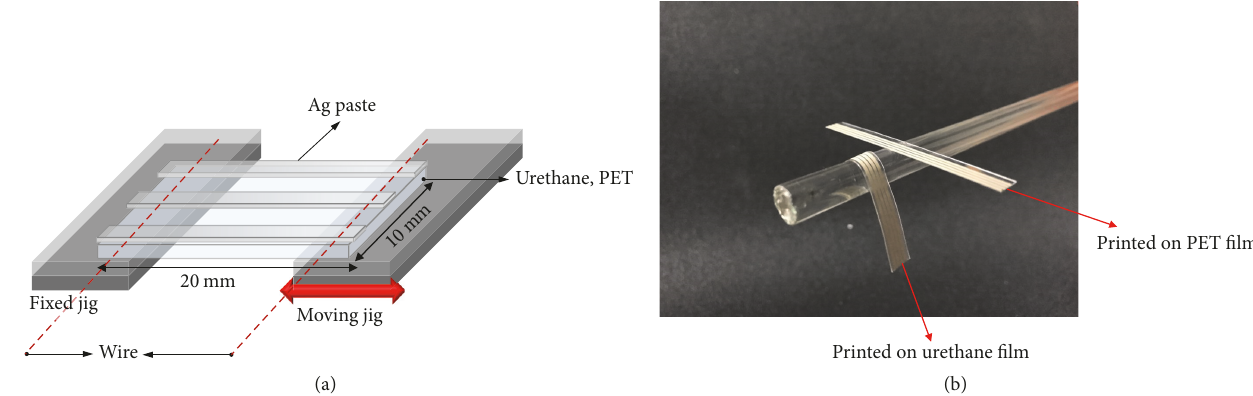
Figure 2: Screen printing of Ag paste: (a) electrode pattern and (b) Ag electrodes on polyester and polyurethane films.